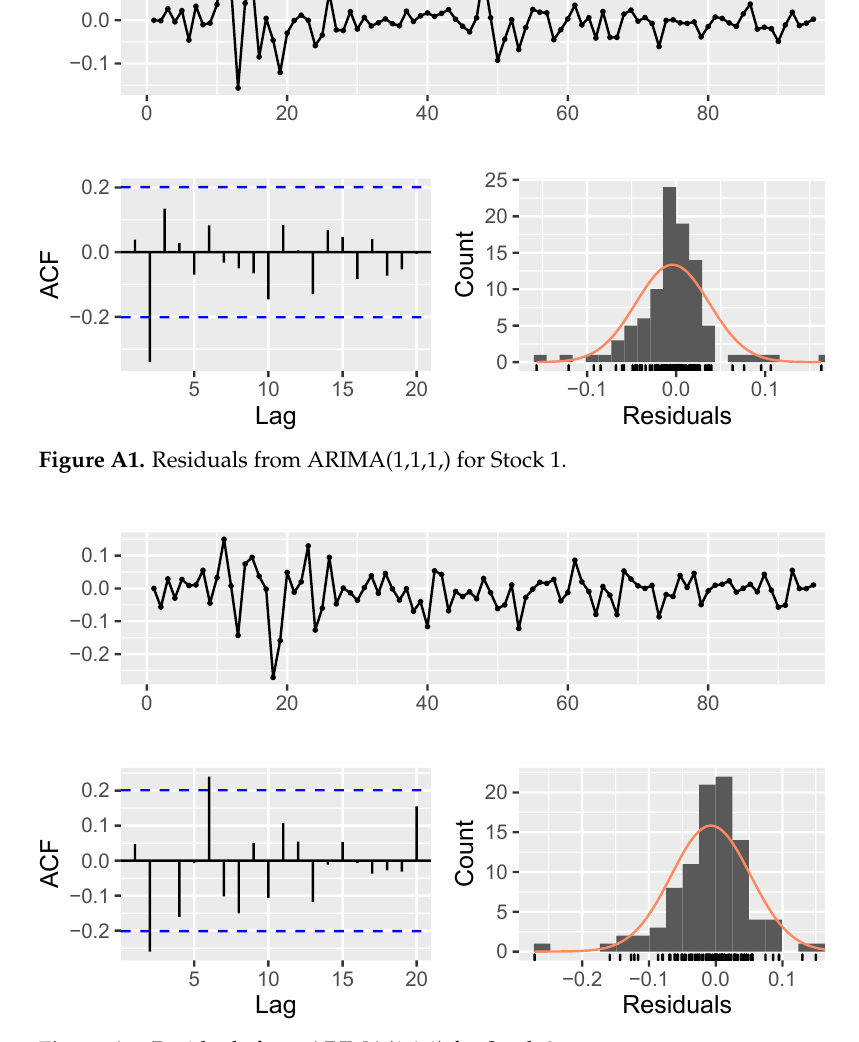
Figure A2. Residuals from ARIMA(1,1,1) for Stock